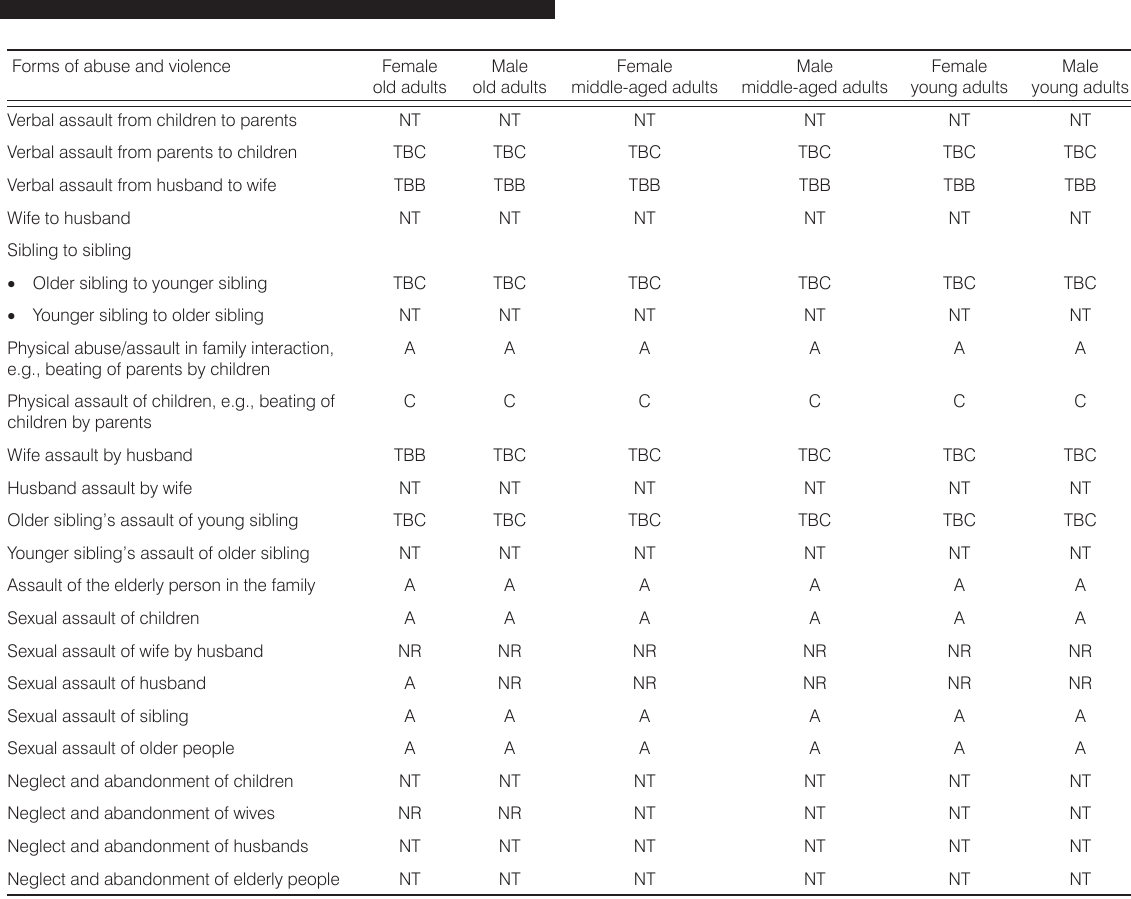
Table 1. Identified forms of violence and the perceived societal responses